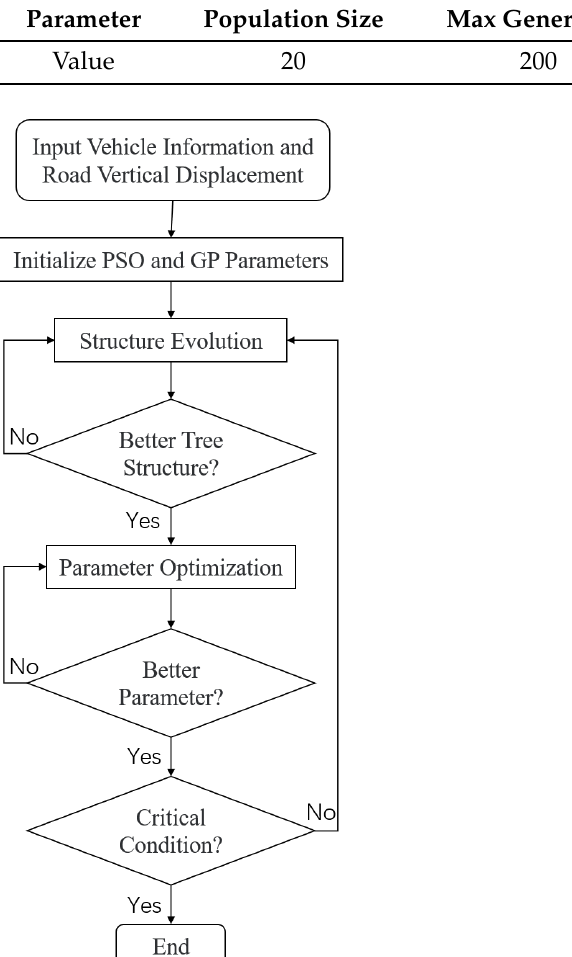
Figure 5. FNT optimization flow